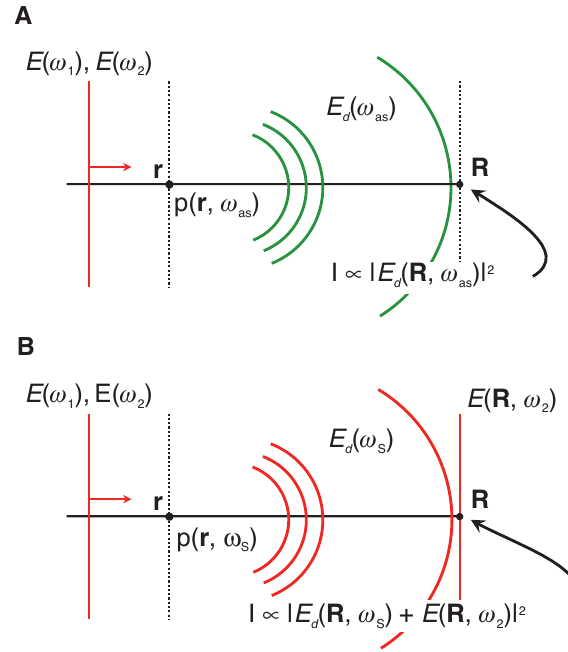
Figure 7: Far-field detection of the radiating nonlinear polarization. (A) CARS. A nonlinear polarization in molecule at r is prepared by incoming fields E ( ω ) and E ( ω ), producing dipole radiation at 1 2 = 2 ω ω − ω . The resulting field E ( ω ) is detected on a far-field as 1 2 d as detector in a homodyne fashion. (B) SRG. The nonlinear polarization = ω radiates at ω , giving rise to the interference between E S 2 E ( ω ) in the far-field. The SRG signal is proportional to the mixing 2